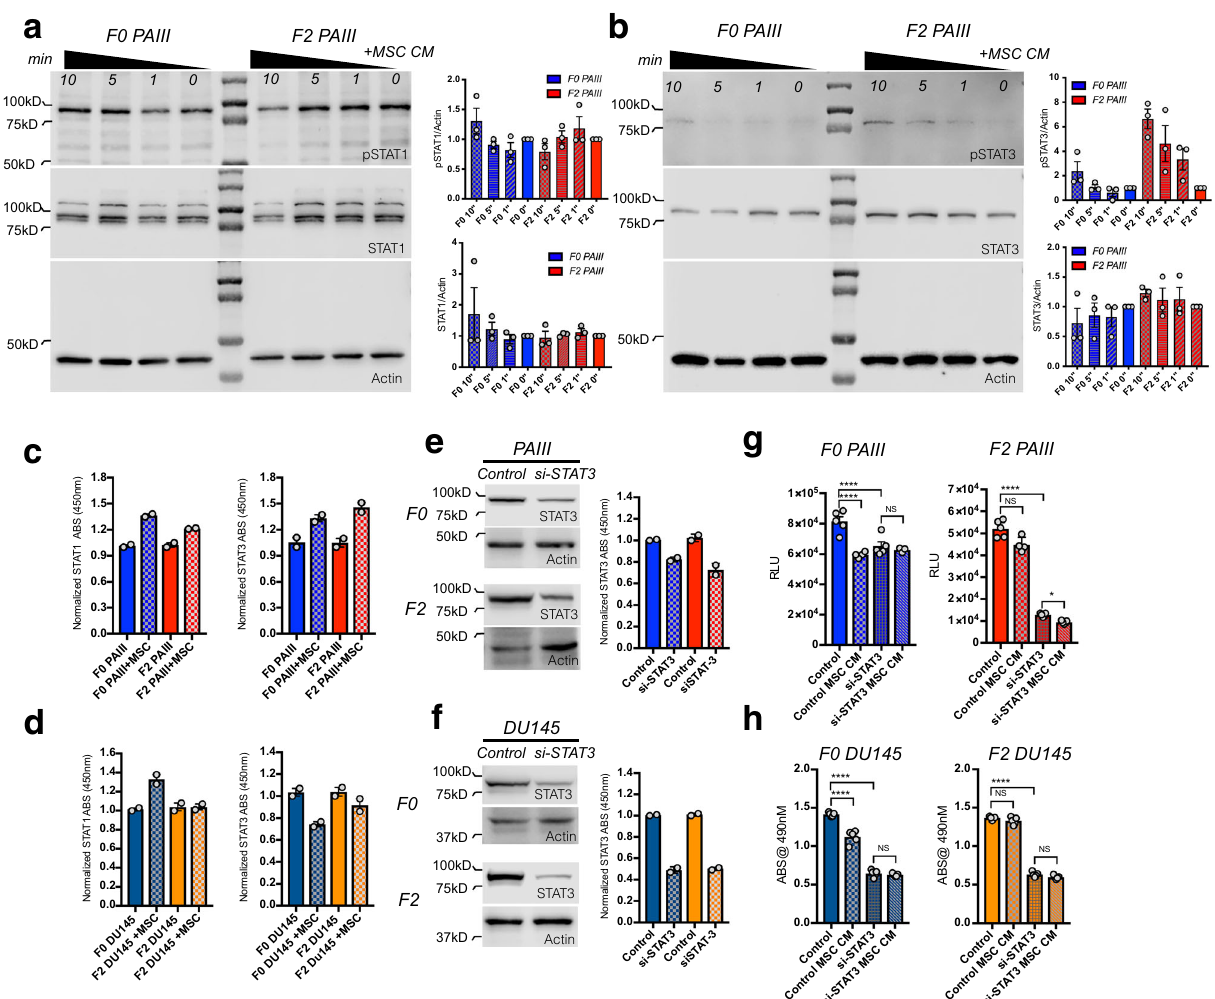
Fig. 6 Elevated STAT3 signaling in MSC selected prostate cancer cell lines. a , b pSTAT1 ( a ) and pSTAT3 ( b ) levels at baseline and in response to MSC CM (50%) over a 10 min (min) period in PAIII parental (F0) and MSC selected (F2) cell lines. Molecular weights are shown in kDa. Actin was used as a loading control. For densitometry, pSTAT and STAT levels were each normalized to their respective actin controls and time responses for F0 and F2 are compared to their respective 0 ’ minute controls that were set at a normalized value of 1. All experiments were repeated on at least three separate occasions with similar results. c , d STAT1 and STAT3 DNA binding activity in the PAIII ( c ) and DU145 ( d ) F0 and F2 cell lines was measured in response to MSC CM for 30 min. Results obtained via absorbance (ABS@450 nm) were normalized to respective controls. e , f STAT3 was silenced (si-STAT3) in PAIII ( e ) and DU145 ( f ) F0 parental and F2 MSC-selected cell lines and the resultant impact on STAT3 activity was measured. Blots show total STAT3. Experiments were independently repeated with similar results. g , h The effect of STAT3 silencing on PAIII ( g ) and DU145 ( h ) cell growth in the presence or absence of MSC CM compared to control treated cells using luminescence assay and relative light unit (RLU) measurement or MTT assay ( n ≥ 3 biologically independent samples). Molecular weights are shown in kDa. Error bars in graphs represent the mean ± SEM and statistical analyses were performed by one-way ANOVA with multiple comparisons at 95% CI. Asterisks denote statistical signi fi cance (* p ≤ 0.05, ** p ≤ 0.01, *** p ≤ 0.001, **** p ≤ 0.0001) while NS denotes not signi fi